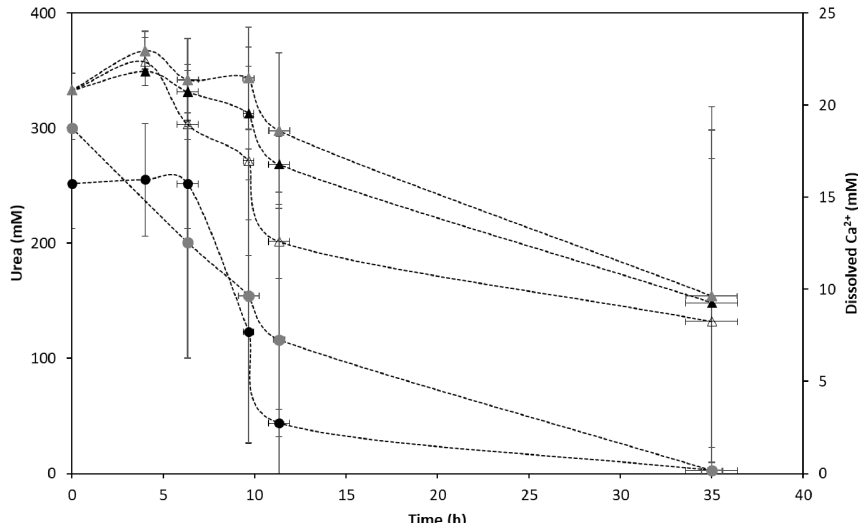
Figure 5. Changes in urea (triangle markers) and dissolved calcium (circle markers) concentrations over time in anaerobic experiments with S. pasteurii in calcium-inclusive medium with NO − (black solid markers), calcium-exclusive medium with NO − (open markers) and calcium- 3 3 inclusive medium without added terminal electron acceptor (grey solid markers). Data points are the averages of triplicate experiments; vertical error bars represent the standard deviations of measurements; horizontal error bars indicate standard deviation of the sampling times; error bars are smaller than markers if not